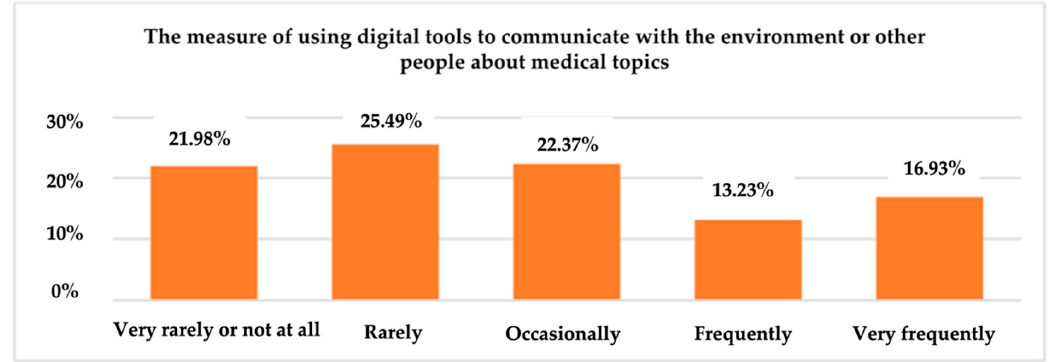
Figure 10. The use of digital tools for communication on medical topics.